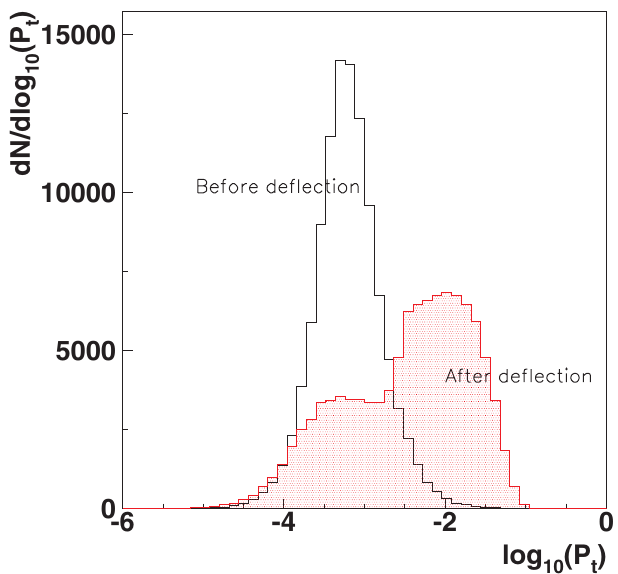
(cid:3) P (cid:4) distribution of the pairs per bunch FIG. 1. (Color) log t 10 crossing before (empty histogram) and after (solid histogram) electromagnetic deflections from the opposite beam, P GeV =c .